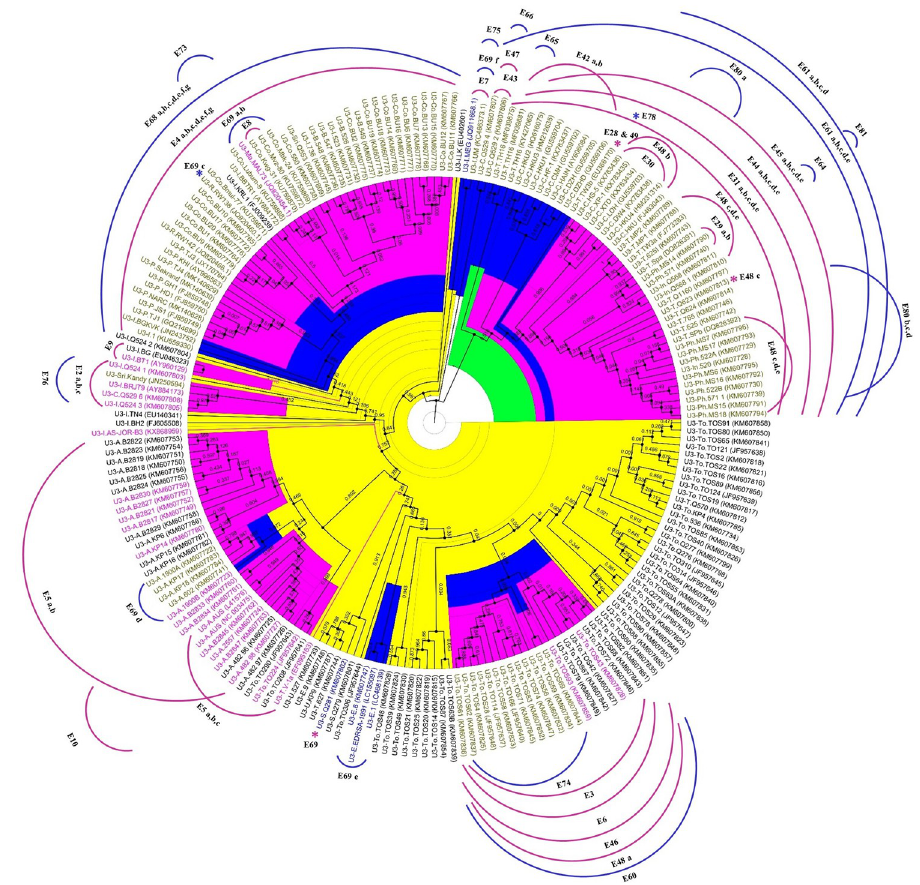
Fig 2. Phylogenetic analysis of BBTV DNA-U3 component illustrating intra and intergenomic recombination events at different nodes. Phylogenetic analysis of DNA-U3 based on nucleotide sequences of BBTV isolates from Pakistan along with previously reported PIO and SEA isolates of BBTV. The evolutionary history was inferred using the Maximum likelihood (ML) method. The percentage of replicate trees in which the associated taxa clustered together in the bootstrap test (1000 replicates). Each sequence is labelled with the GenBank accession number followed by origin and isolate name. The phylogenetic trees were further annotated in FigTree software v1.4.3 (Rambaut, 2010). Light green colour in the circle represents SEA population, while yellow colour represents PIO population. Similar analysis of DNA-R, -S, -M, -C and -N were performed and provided as supplementary figures (S1–S5 Figs) Intergenomic recombination events were marked with pink arc, while Intragenomic recombination events marked with blue arc. Isolates involved in both events were coloured brown. E represents the number of events and a,b,c,d etc. shows different populations in one event detected in RDP. Asterisk sign ( � ) shows only one isolate was involved in recombination at the given node. Arrows on both sides indicates that all the isolates were involved in respective recombination event. Blue arrow on both sides indicates that all the isolates of PIO group were involved in respective recombination event. The recombinant events described in S2 and S3 Tables are marked. Due to recombination different isolates showed intra and intergenomic events at different